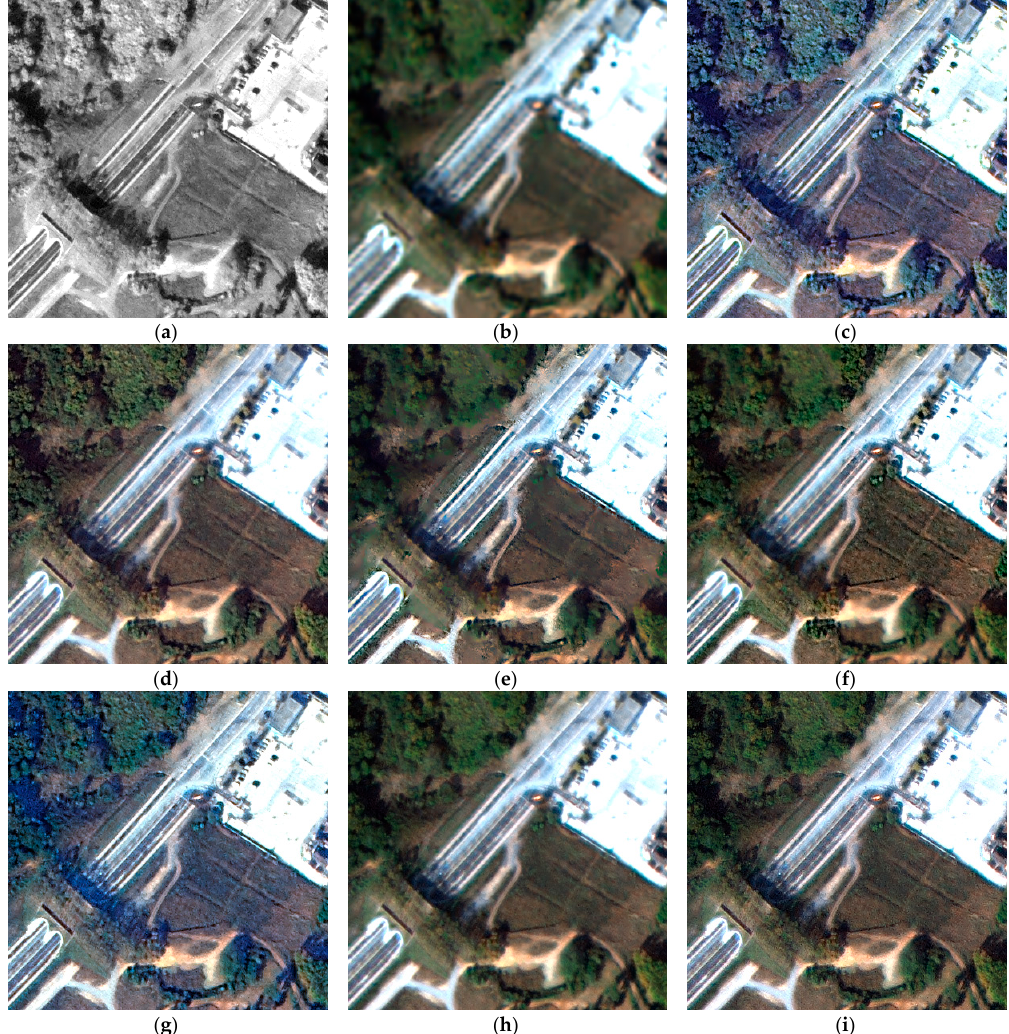
Figure 8. The 400 × 400 details of KOMPSAT-3A true-color (red, green, and blue) composites: ( a ) panchromatic image; ( b ) EXP ; ( c ) GIHS ; ( d ) GSA G ; ( e ) GSA L ; ( f ) BDSD ; ( g ) NNDiffuse ; ( h ) HP-NDVI spectral ; ( i ) HP-NDVI spatial .